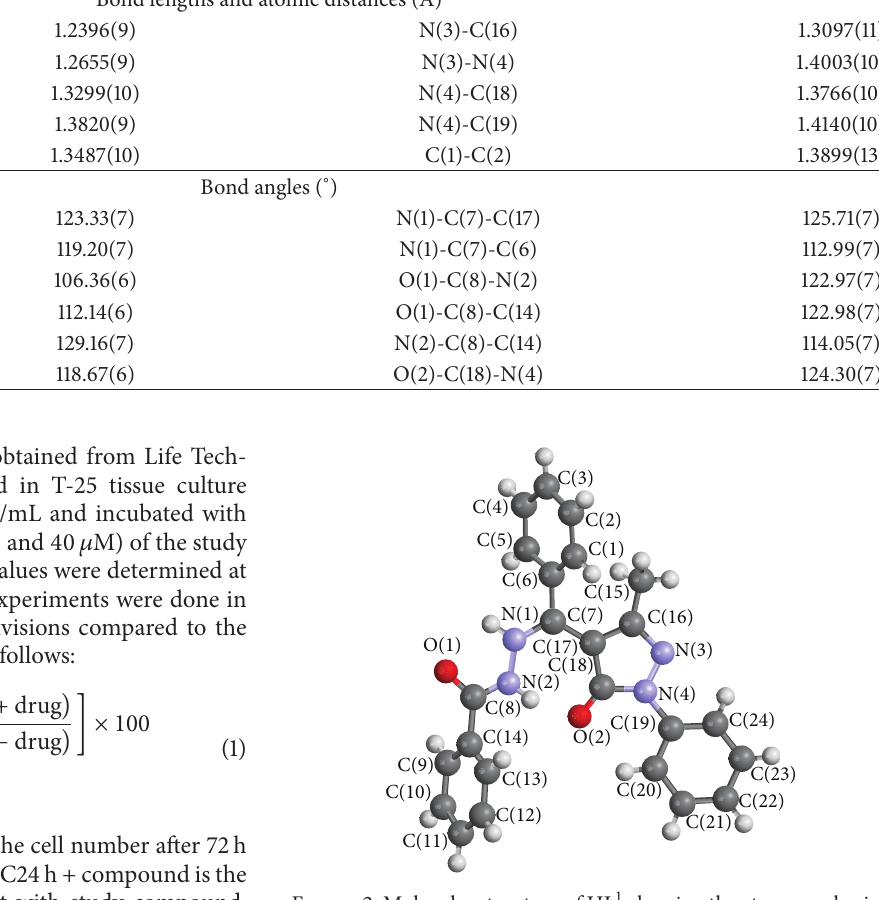
Table 1: Selected bond lengths (˚A) and bond angles ( ∘ ) for HL 1 (estimated standard deviations are in brackets). Bond lengths and atomic distances (˚A)